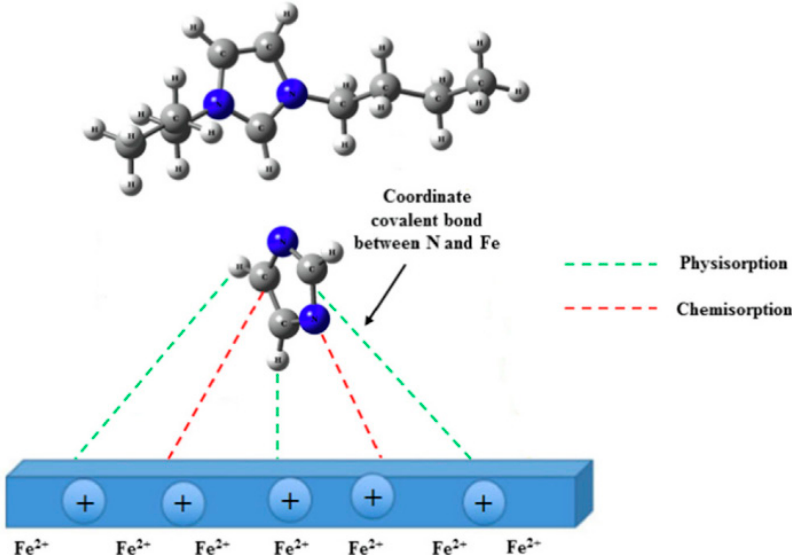
Figure 2. IBEI3 Schematic diagram on steel surface at a saturated CO 2 concentration of 3% ( m / v ) [25]. Guo and Kozaderov et al. [34] explored the corrosion inhibition behavior of triazoles with different alkyl chain lengths by the density functional theory. Electrons were distrib- uted on the triazole ring, meaning that the preferred position for the electrophilic reaction of the compound was likely to be on the ring, and the adsorption was in a planar config- uration. The absolute value of adsorption energy increased with the increase in alkyl chains, and the corresponding inhibition efficiency also followed the same law. Koza- derov [33] concluded that the longer the length of the triazole alkyl chain, the greater their inhibition effect for a copper corrosion system in a medium of sodium chloride with a multi-component passivation film formed on brass, including ZnO·xH 2 O, Cu 2 O and CuO oxides and a small number of soluble complexes of zinc and copper with the studied in- hibitor molecules. Yoo et al. [37] synthesized a series of tris(carboxy alkylamino)triazines with varying lengths of the alkyl chain and found that they were mixed adsorption corro- sion inhibitors that demonstrated a corrosion inhibition efficiency value that increased strongly with an increasing alkyl chain length. Hu et al. [38] synthesized BTC 6 T and BTC 8 T